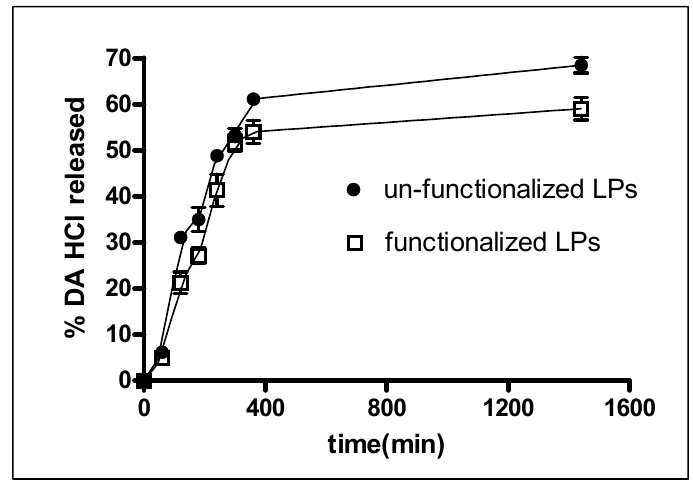
Figure 3. Release profiles of DA ∙ HCl from LPs. Data are the mean of three determination.